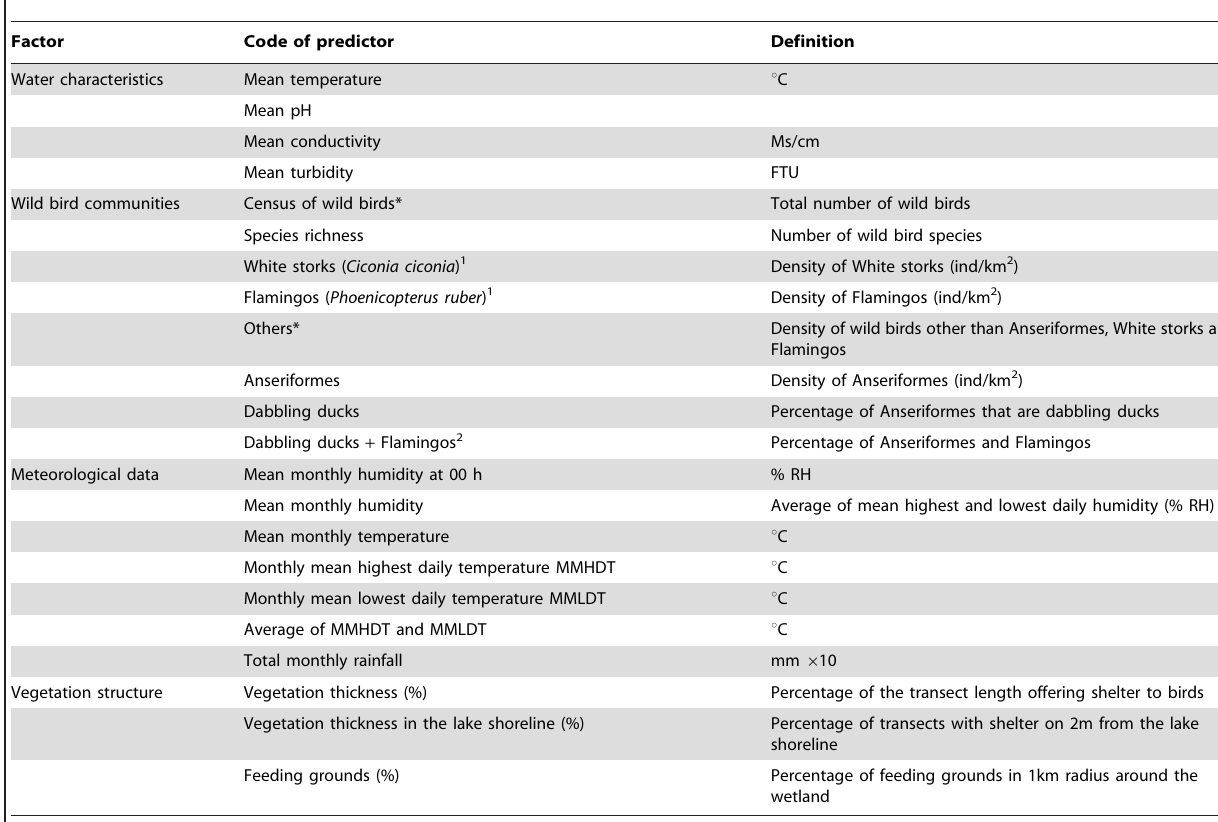
Table 1. Explanatory variables used to model AIV prevalence in Spanish wetlands.